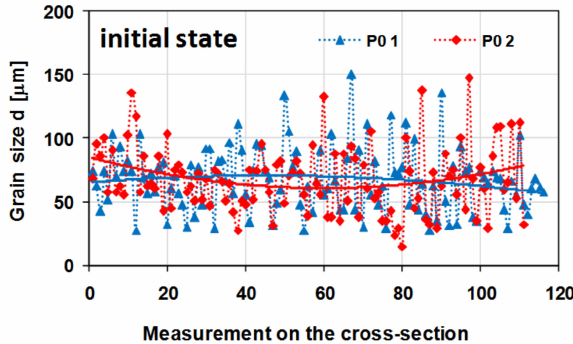
Figure 18. Changes in the grain size on the cross-section of the sample made of the 5019 aluminium alloy; the measurements were performed in two perpendicular directions (as shown in Figure 15); P0—the initial state of the material (after